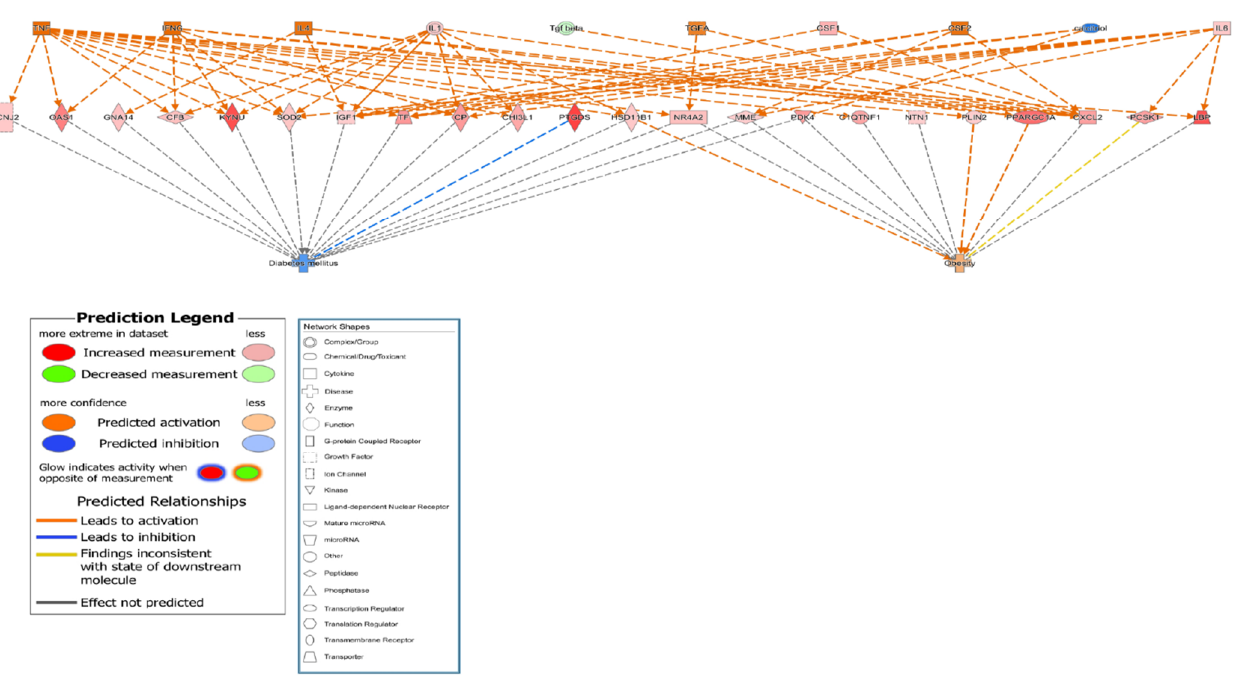
Figure 3. Functional relationship networks of osteoporosis-related genes involved in the canonical pathways of obesity and diabetes development. Functional relationship networks for control subject no. 3 compared with three participants in the osteoporosis group (no. 6, 8, and 9). 3.5. Common Related Genes in Osteoporosis, Sarcopenia, Diabetes, and Obesity The IPA results revealed 10 common candidate genes ( CFB, CXCL2, HSD11B1, IGF1, IL6, NTN1, PCSK1, PPARGC1A, SOD2, and TF ) that were inhibited in osteoporosis, sarcope- nia, and diabetes but activated in obesity for all participants in the control group (Figure 4). Furthermore, IPA data suggested that activation of HSD11B1 and PPARGA1A resulted in obesity, but the other eight candidate genes were not significantly associated with obesity.